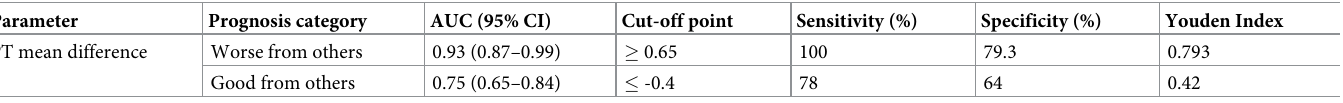
Table 7. The prognostic value of a gradual change of prothrombin time over the 7th-day among COVID-19 patients attending the Tibebe Ghion Specialized Hospi- tal, COVID-19 treatment center 2021 (n = 100). Parameter